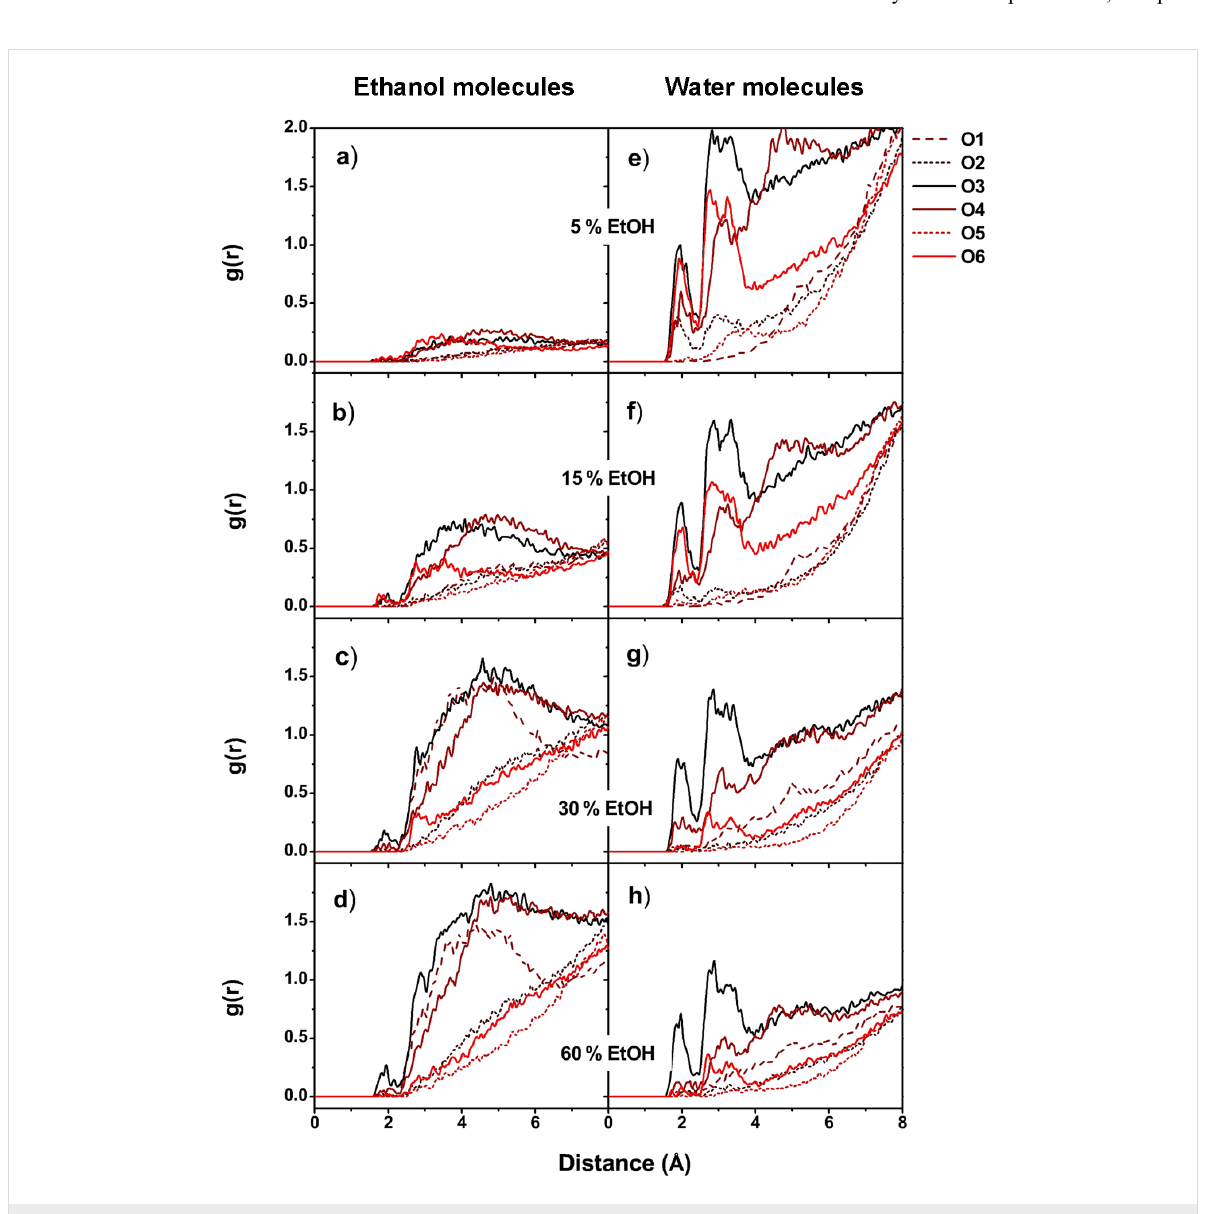
Figure 6: Radial distribution functions (RDF) of (a–d) ethanol, and (e–h) water molecules around the oxygen atoms of α -MGS on complexation with β -CD at different ethanol percentages.